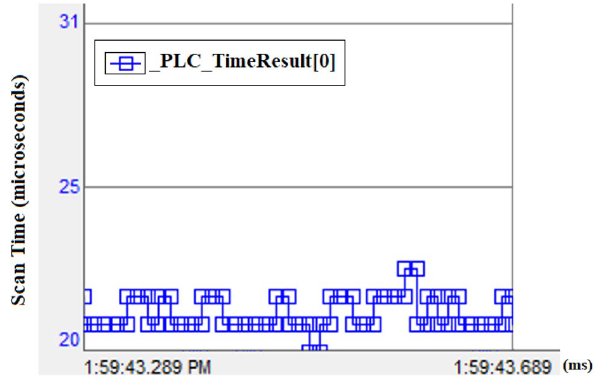
Fig. 29 Scan-time values during the skipping code attack